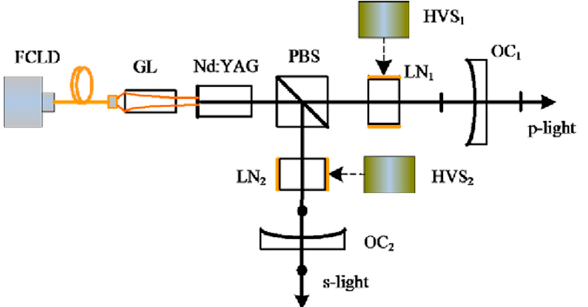
Figure 31. Schematic of two-cavity dual-frequency Nd:YAG laser [37]. FCLD: fiber-coupled laser diode; GL: gradient-index lens; PBS: polarizing bean splitter; LN: lithium niobate; HVS: high-voltage source; OC: output coupler.